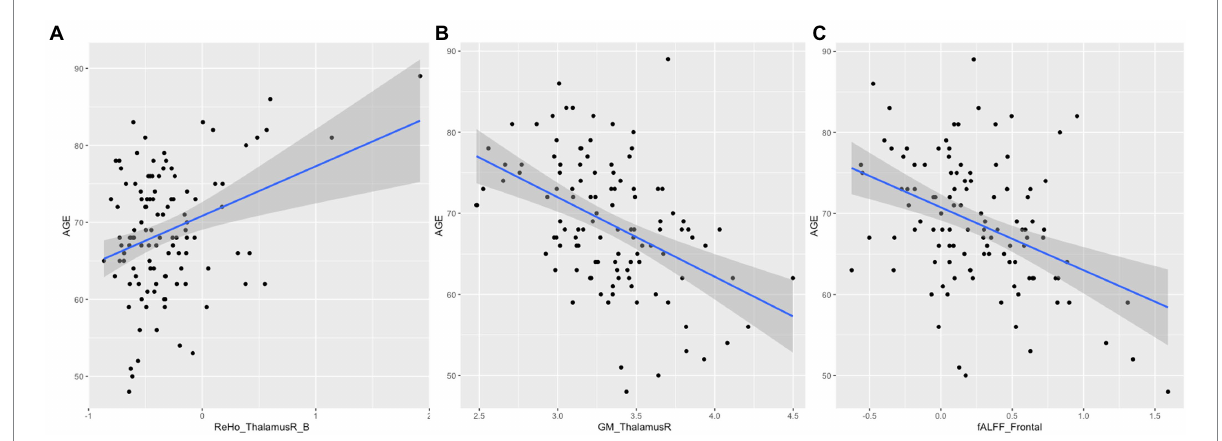
FIGURE 4 Scatter plot and regression for age. (A) Represents age and ReHo signal of the right thalamus; (B) Represents age and gray matter volume of the right thalamus. (C) Represents age and fALFF signal of the frontal